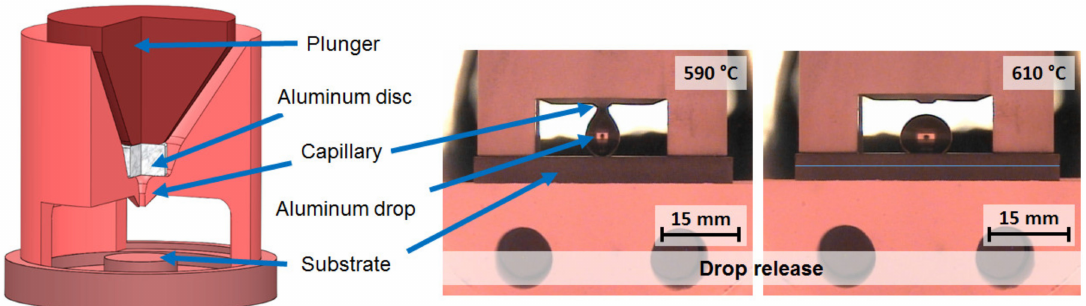
Figure 1. Design of the developed capillary purification system used for wettability tests ( left ) with exemplary images of drop release ( right